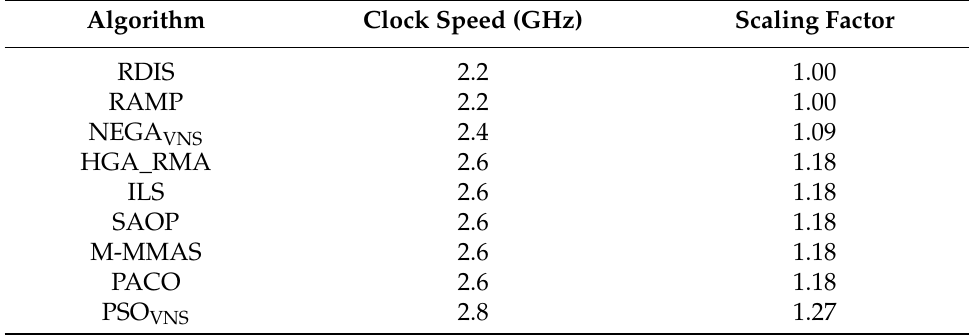
Table 2. Scaling factor computed for each CPU.